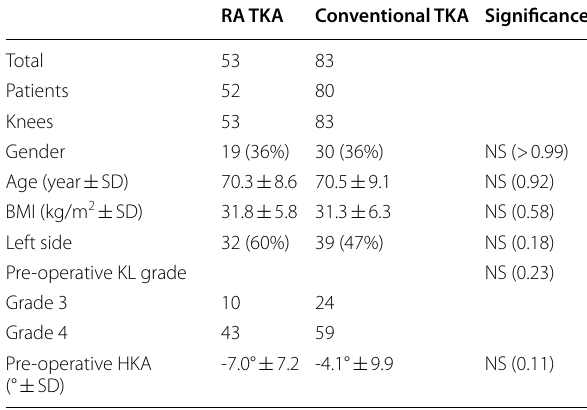
Table 1 Characteristics of patients undergoing RA TKA and conventional TKA